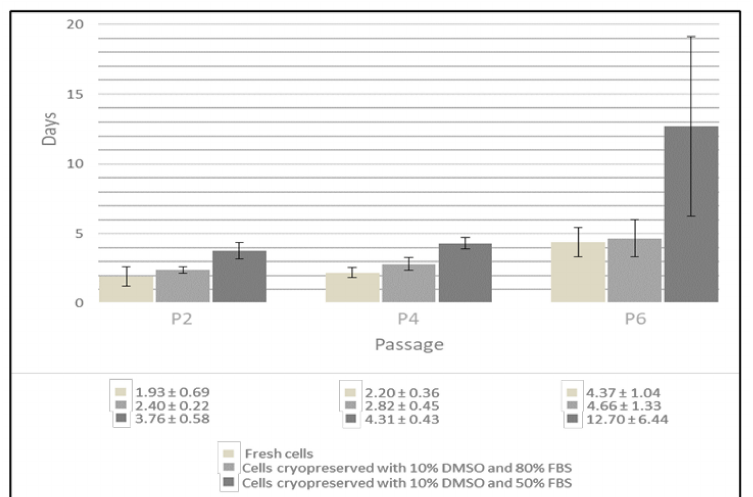
Figure 3. Analysis of population doubling time (pdt) of fresh cells and cells cryopreserved with 10% DMSO and 50% and 80% FBS ( n = 10) at passages P2, P4 and P6. The pdt in fresh cells and in cells cryopreserved with 80% FBS shows the same trend in the three passages considered. Cells cryopreserved with 50% FBS show a delay in cell division at all passages compared to fresh